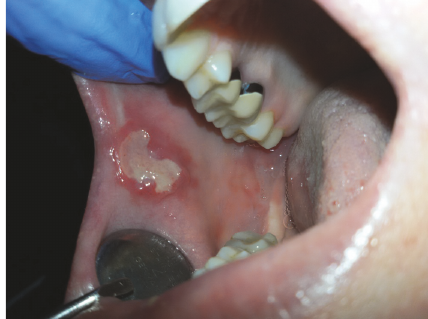
Figure 1: The first presentation of the lesion, after topical corticos- teroids applications.